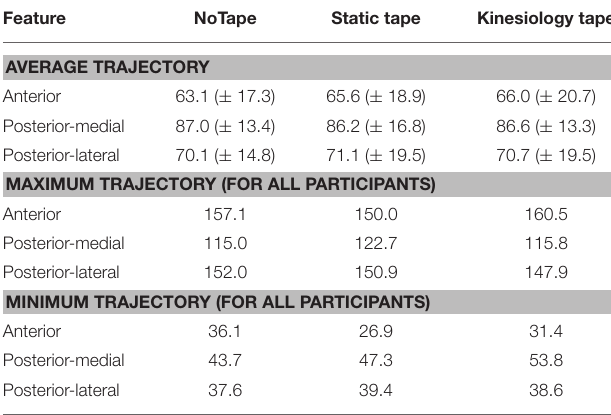
TABLE 1 | Characteristics of participants for gender. Gender